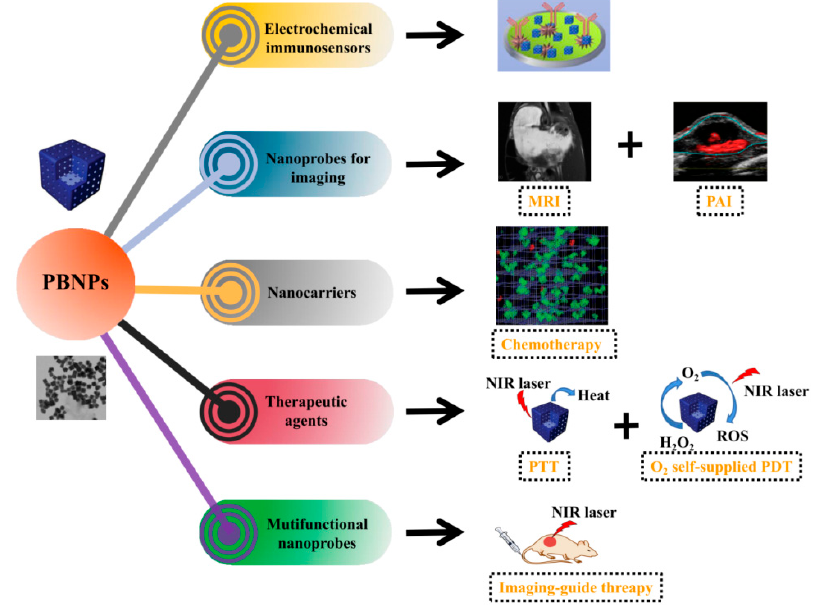
Figure 1. The schematic illustration of PBNPs in the applications of tumor diagnosis and therapies.